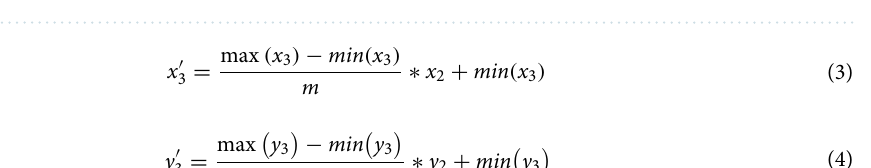
Figure 18. Feature line extraction neural